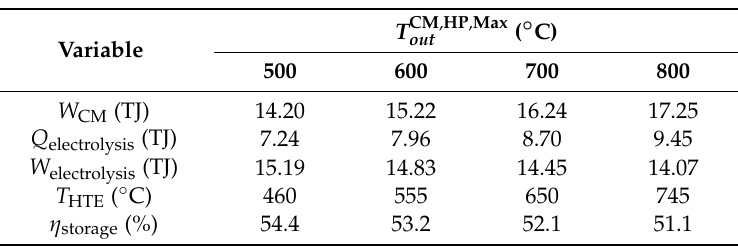
Table 3. Sensitivity of the CAES-HTE results to the maximum exit temperature of the HP compressor ( T CM,HP,Max ). Results are based on an ideal out